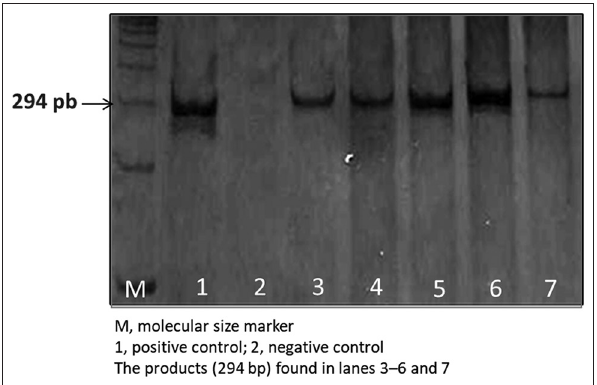
Figure-2: Results of the gel electrophoresis for polymerase chain reaction products of the glmM gene of the Helicobacter pylori isolates from cow milk.